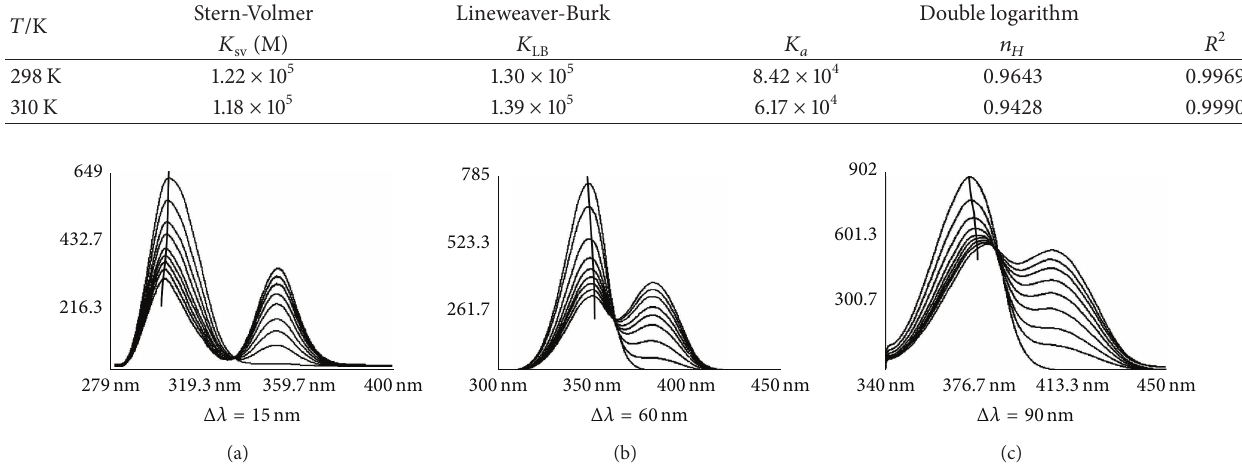
Table 2: The binding parameters of warfarin-HSA at different temperatures.